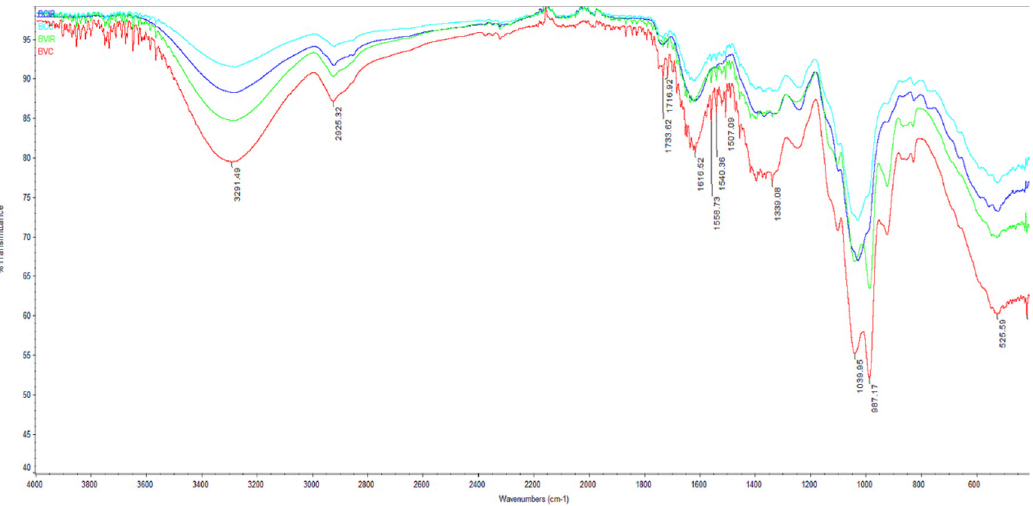
Figure 3. Fourier-transform infrared spectroscopy spectra of red beetroot dried samples: BV C , BC C —red beet purée dried by convection method; BV IR , BC IR —red beet purée dried by infra-red (IR) method.